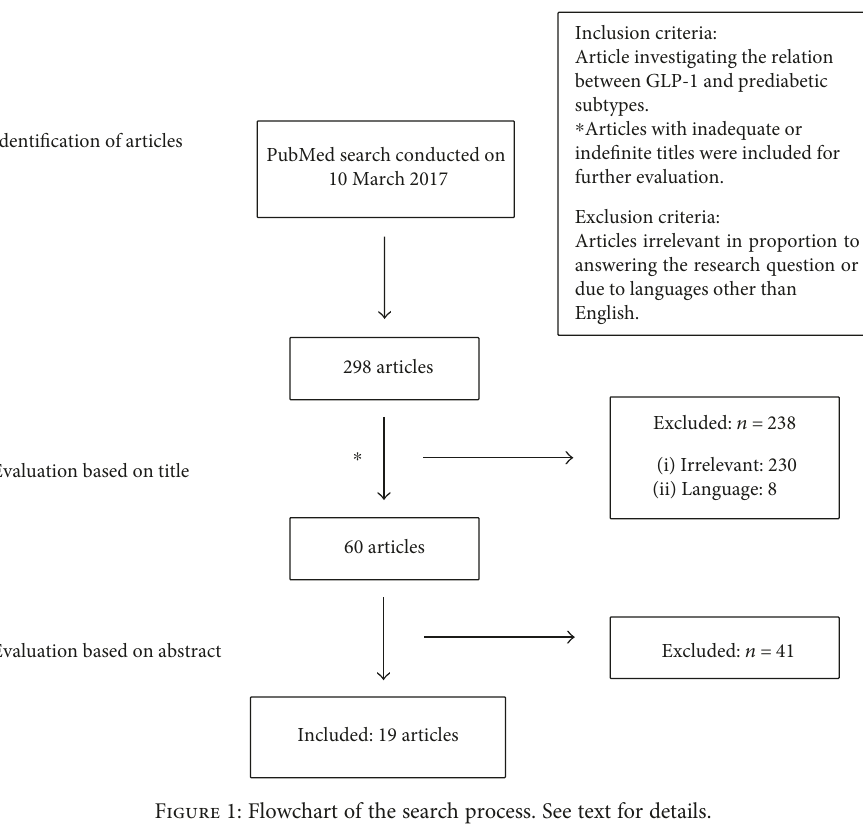
Figure 1: Flowchart of the search process. See text for details.